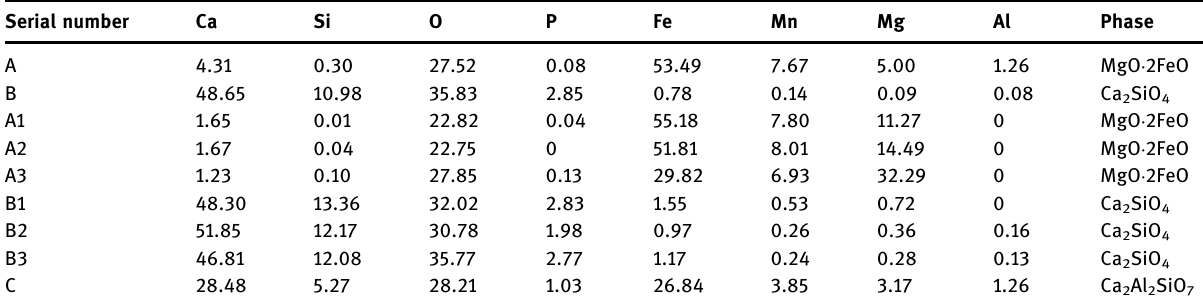
Table 4: Each phase and element content of Baogang steelmaking slag wt% Serial